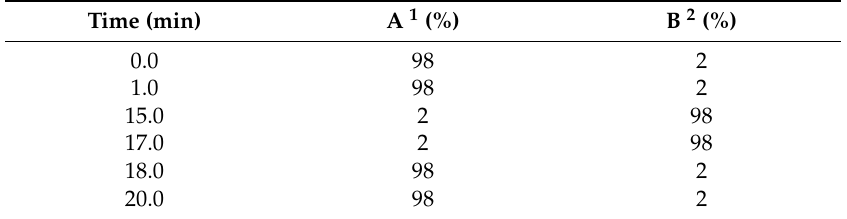
Table 1. The makeup of the mobile phase for the gradient